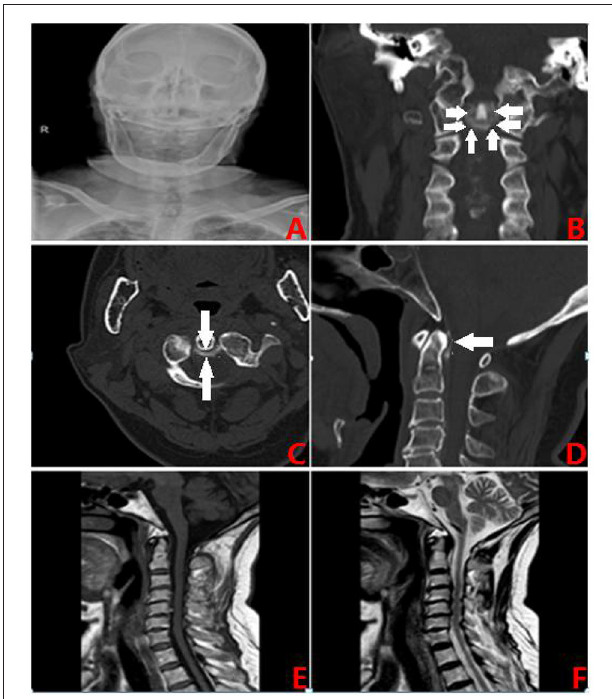
FIGURE 1 | (A) The X-slice. (B) CT coronal section: crown sign. (C) CT transverse position: ring high. (D) CT Median sagittal section: linear calcification. (E) MRI T1 phase. (F) MRI T2